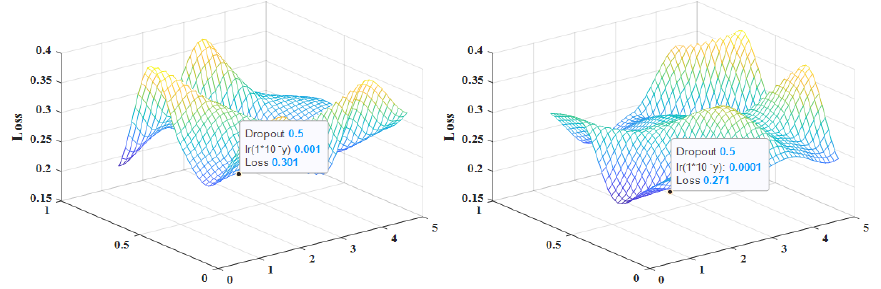
Figure 3. Parameter tuning situation. (NSL-KDD & UNSW-NB15).